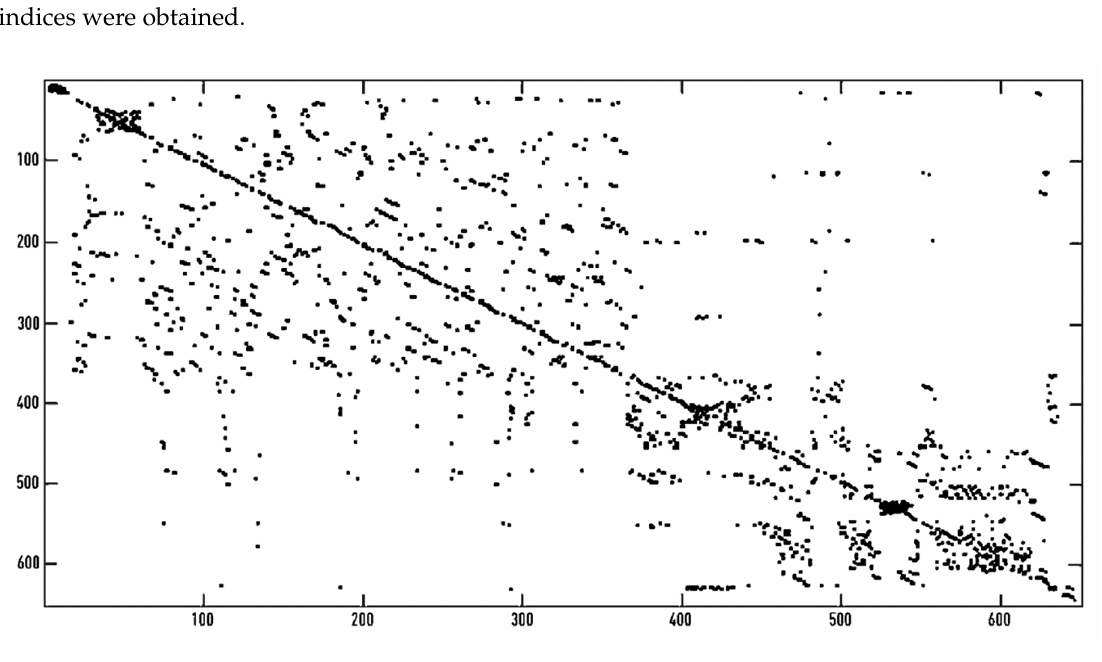
Figure 3. (Log) bicoherence matrix obtained from a 10-min ECG trace. Frequencies are multiples of 0.01 Hz, thus a value of 116 corresponds to 1.16 Hz (69.6 beats per minute).